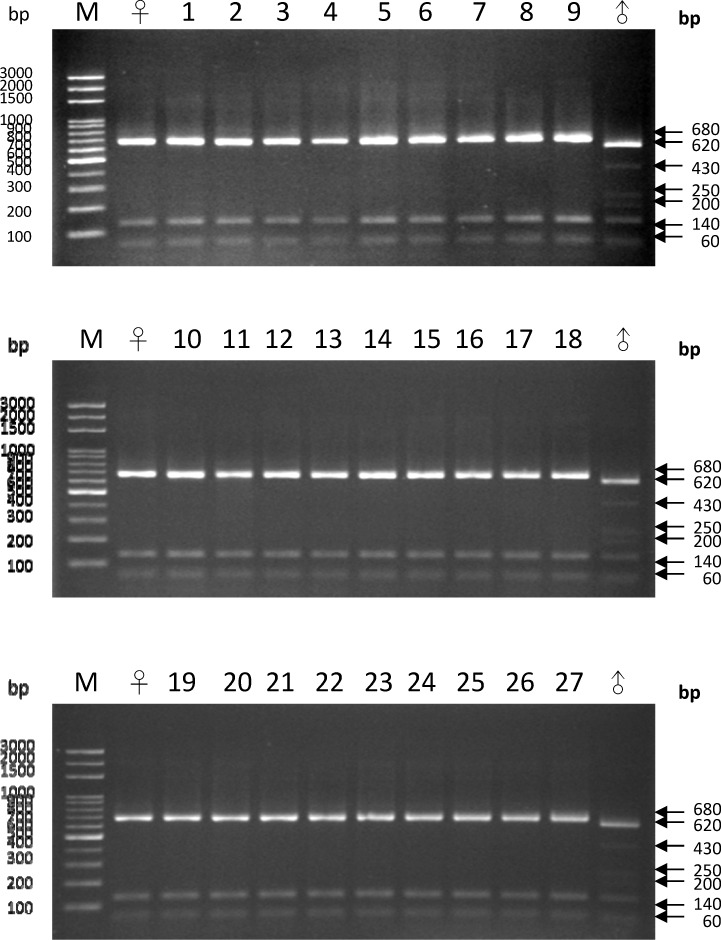
PCR-RFLP analysis of the external transcribed spacer (ETS) of nuclear ribosomal DNA.The PCR product of each sample was cut with the HaeIII restriction enzyme. Lanes ♀ and ♂ represent the maternal parent (Ascocenda John De Biase ‘Blue’) and the paternal parent (Phalaenopsis Chih Shang's Stripes), respectively. Lanes 1–27 represent the 27 F1 hybrids. M: 100-bp DNA ladder marker.